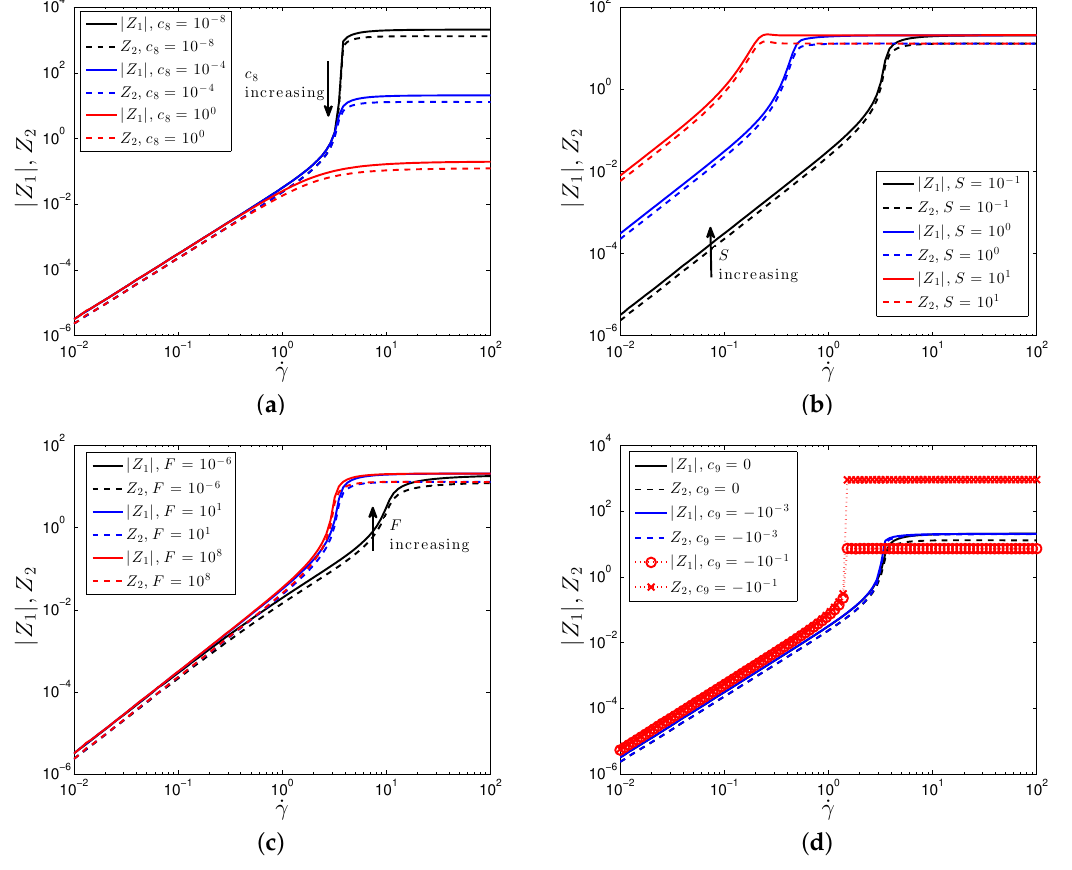
Figure 4. Plot of the first and second normal structure differences, Z 1 , Z 2 , against shear rate for varying values of ( a ) c 8 , ( b ) S , ( c ) F , and ( d ) c 9 . Parameter values are: S = 10 − 1 , F = 10, c 3 = − 23.5, c 7 = − 0.47, c 8 = 10 − 4 , c 9 = 0, η S = 1, f ( φ ) = 1.0957, k 1 = − 10 3 , k 4 = −